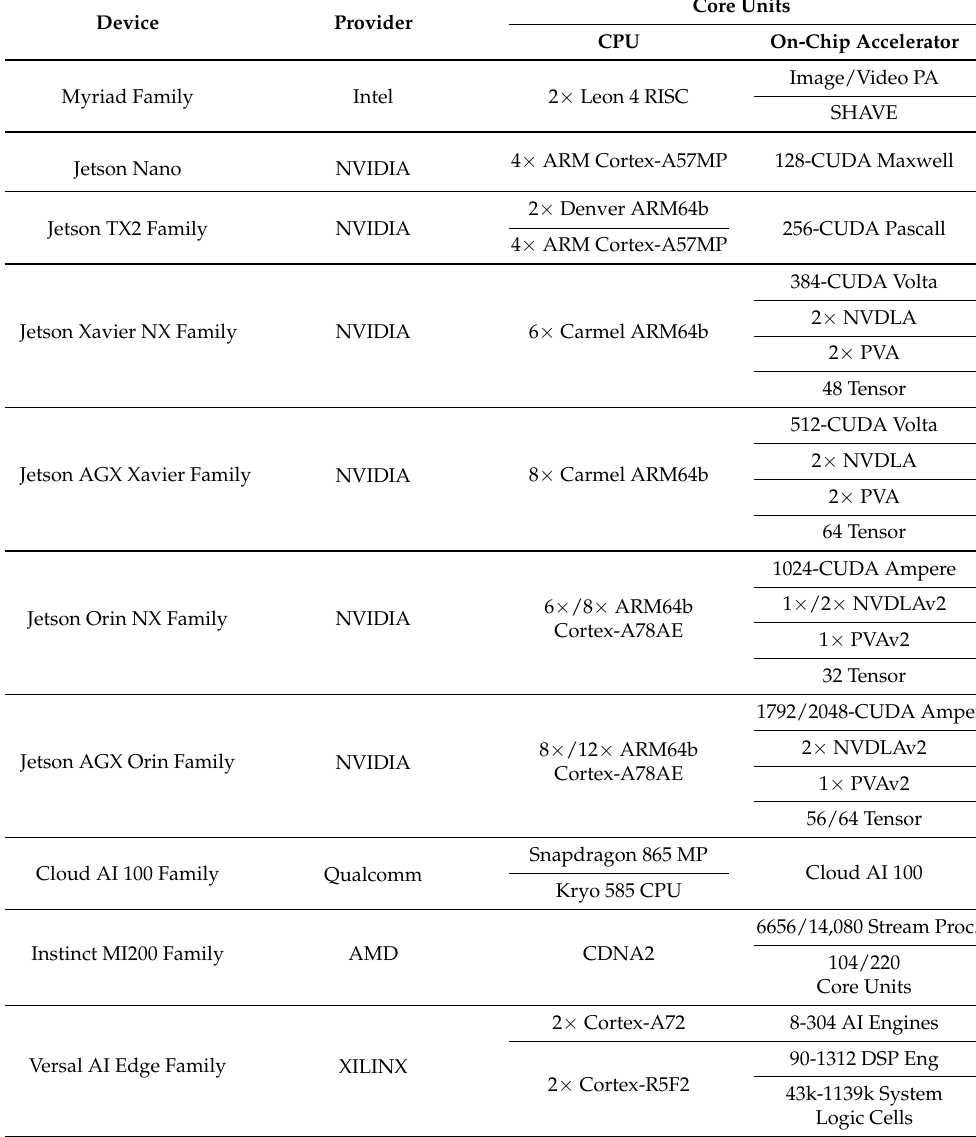
Table 3. Trade-off of the AI chipsets and boards under consideration: Core